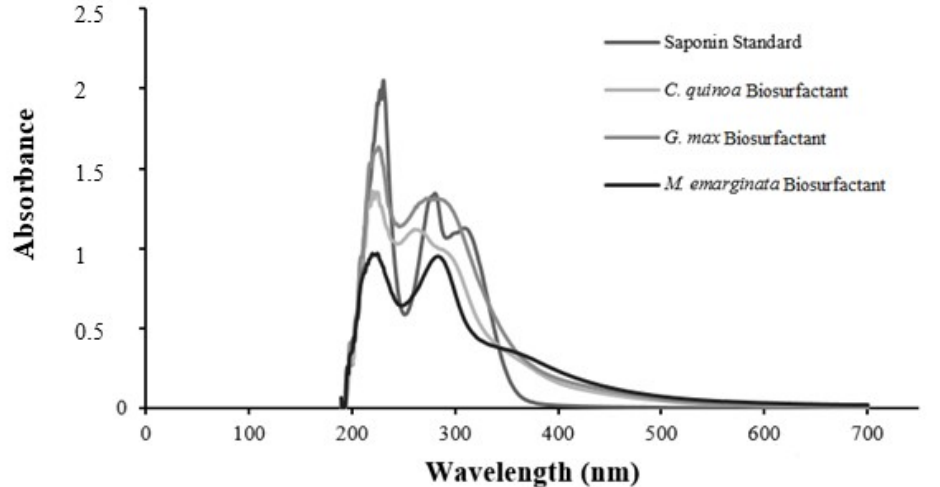
Figure 10. UV spectra of standard saponin (Sigma) ( λ max 220 and 285 nm) and biosurfactants from Chenopodium quinoa ( λ max 220 and 270 nm), Glycine max ( λ max 220 and 290 nm), and Malpighia emarginata ( λ max 220 and 285 nm).